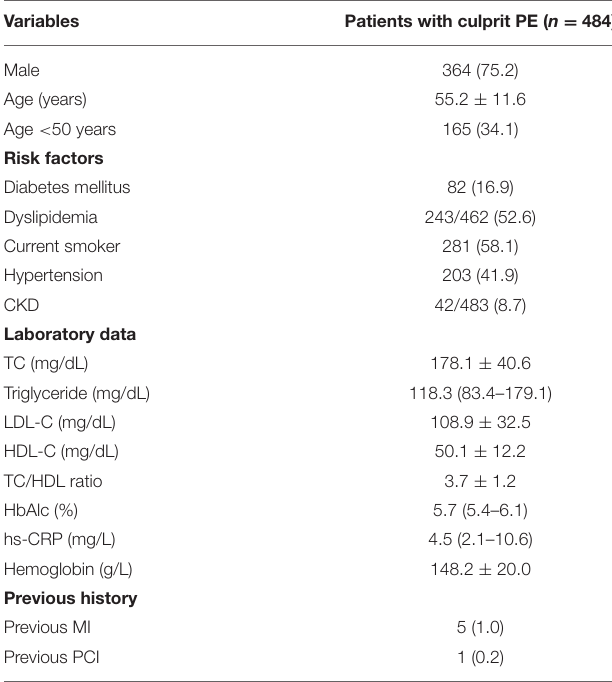
TABLE 1 | Baseline characteristics and laboratory findings of STEMI patients with culprit plaque